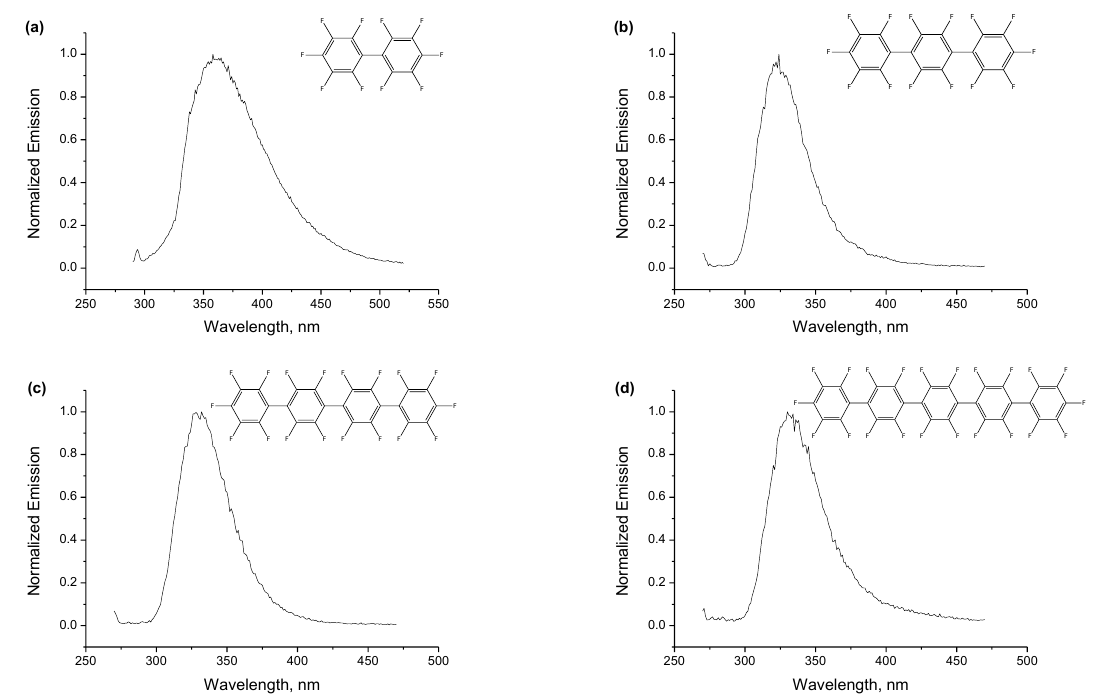
Figure 2. Normalized emission spectra of the four compounds (( a )— 1 , ( b )— 2 , ( c )— 3 , ( d )— 4 ) in acetonitrile. Positions of the emission maxima are collected in Table 1. Excitation at 270 nm for 1 and 250 nm for 2 , 3 , 4 . The raw emission spectra are given in the Supporting